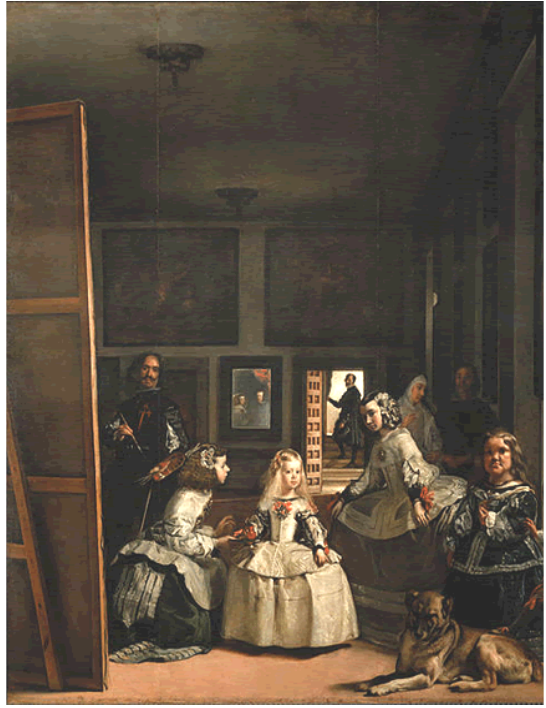
Figure 7 Velasquez, maids of honor,1656; oil on canvas museum of madrid, 318cm